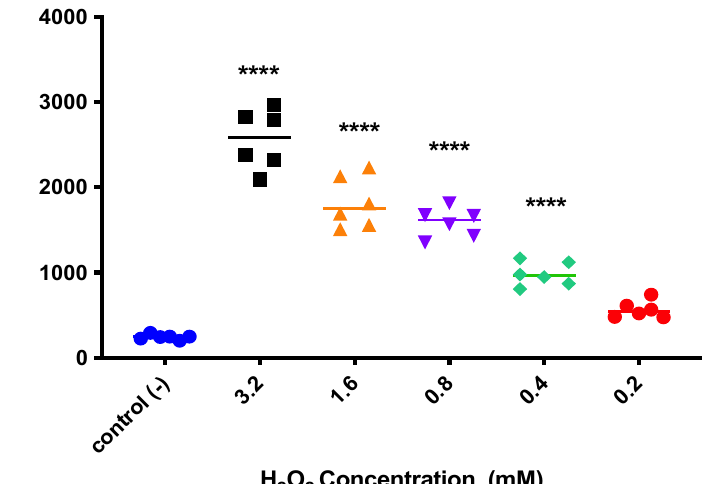
Figure 2. Evaluation of oxidative stress in HUVECs treated with H2O2. The cells were exposed to Figure 2. O 2 , it is important to emphasize that the dose selected (0.4 mM) in this study was supported different concentrations of H 2 O 2 for 4 h and the amount of fluorescence emitted was then measured in the results from two different cytoxicity methods and the evaluation of oxidative stress through using the CM-H 2 DCFDA probe assay. Data are presented as the mean ± standard deviation of the CM-H 2 DCFDA probe. On the other hand, the strategy to evaluate the induction of oxidative the results obtained in independent experiments. Statistically significant differences are indicated stress could also be contributing to the differences found, because this measures the general pro- compared to controls (**** = p < 0.0001; n = duction of ROS; therefore, to improve this aspect, it would be highly beneficial to incorporate the specific measurement of the by-products formed from the decomposition of the H 2 O 2 or the antiox- idant enzyme activity (catalase or glutathione peroxidase) in the supernatant of the cell culture. In summary, the differences encountered could be due only to the standardized conditions and the cell model used; therefore, 0.4 mM H 2 O 2 is the optimal concentration to be able to study it (**** = p < 0.0001).